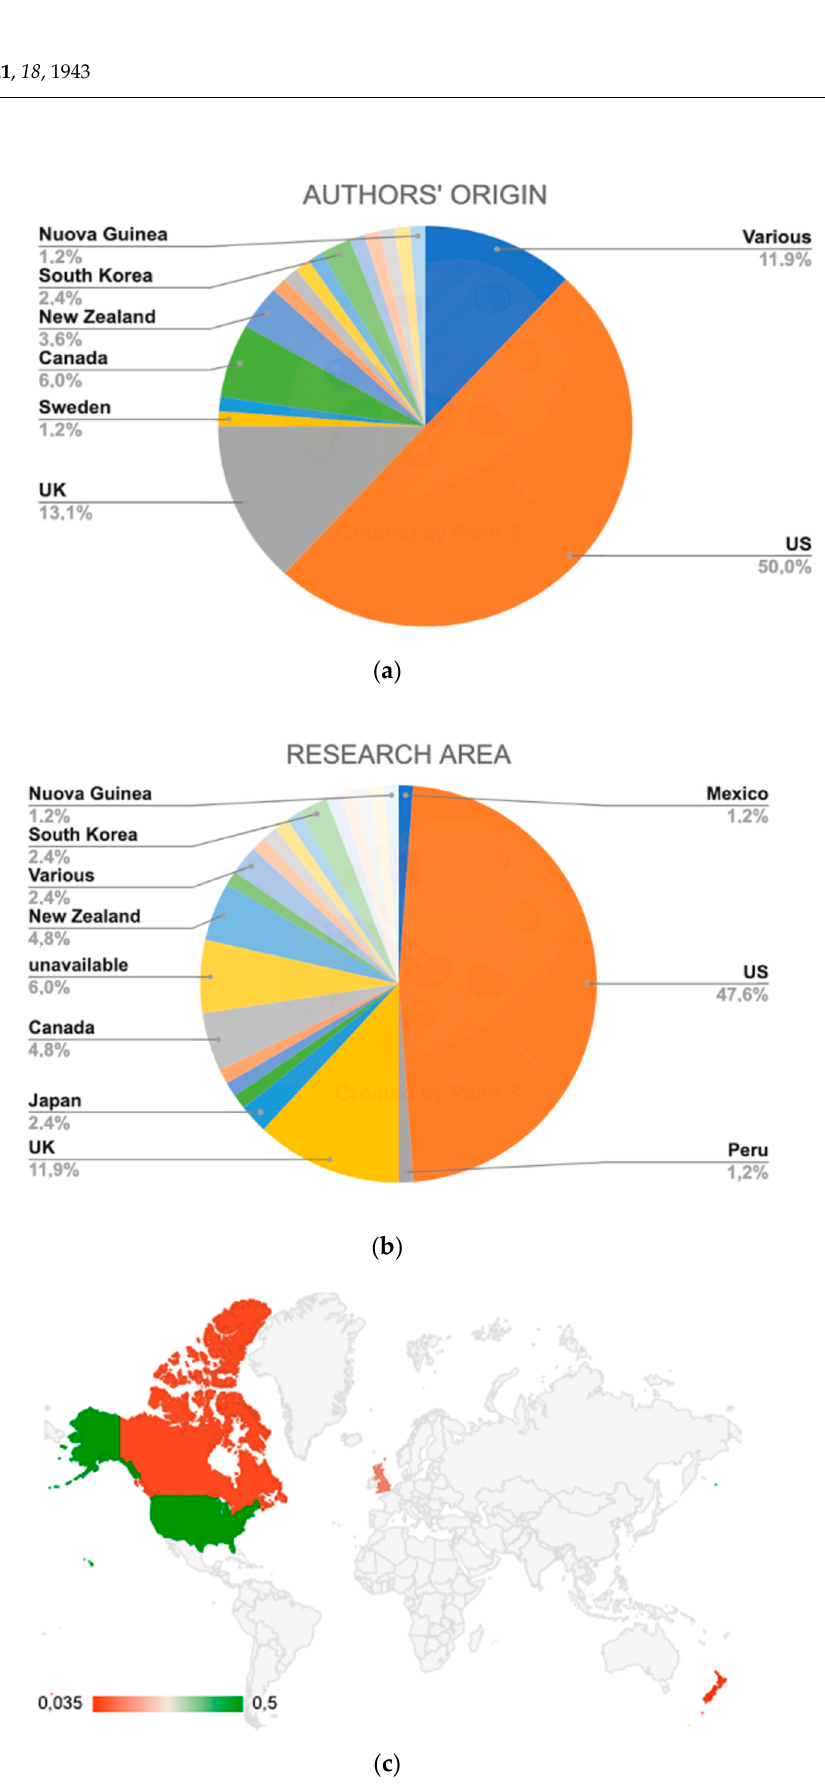
Figure 2. ( a ) Origin of the publications’ authors; ( b ): Geographical areas of research; ( c ): Geographical interest of the research topic.